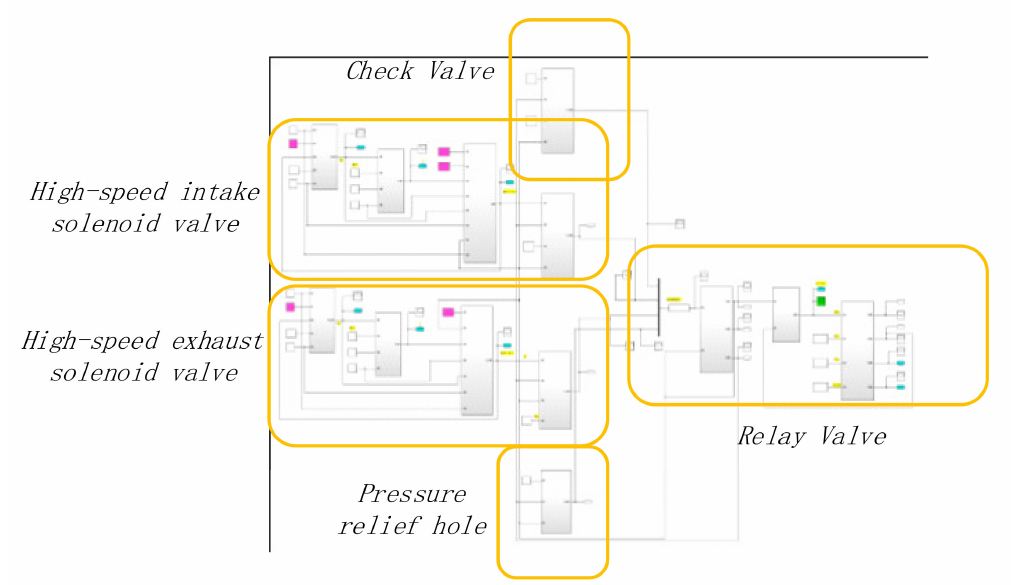
Figure 6. Simulation model of an automatic pressure regulating valve in electronic-controlled pneumatic braking system of commercial